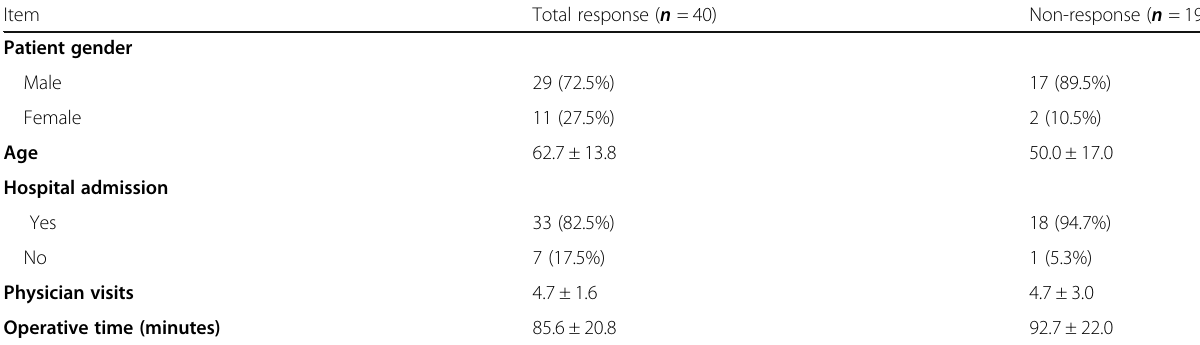
Table 2 Summary of statistics relating to demographic and clinical variables of interest for included patients and non-response patients. Categorical variables are presented as n (%) and continuous variables as the mean (± SD)